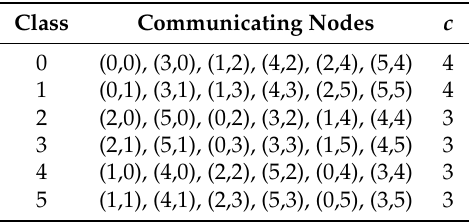
Table 1. Class table (CT) for N = Q = 6, t = 4, s =